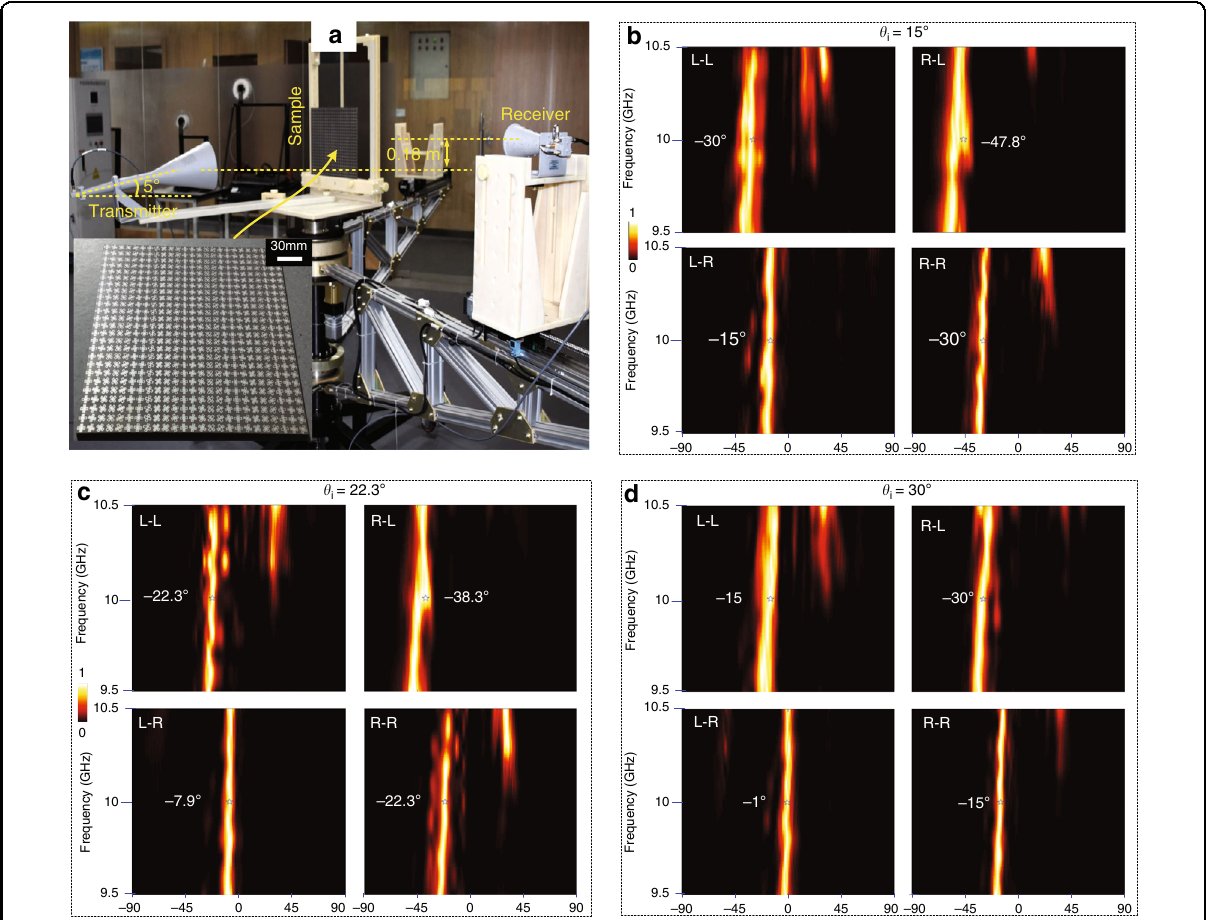
Fig. 5 Experimental characterization of the spin-and-momentum multiplexed retrore fl ector under three angles of incidence. a Far- fi eld scattering measurement setup using a 2D rotary table. Scattering intensity map (| E |^2) of the retrore fl ector from 9.5 to 10.5 GHz within − 90 – 90° in steps of 1° at b θ i2 = − 15°, c θ i3 = − 22.3° and d θ i1 = − 30° by switching the handedness of CP input and output. All patterns are normalized to their maximum. Here, the theoretically calculated beam angle is indicated by blue